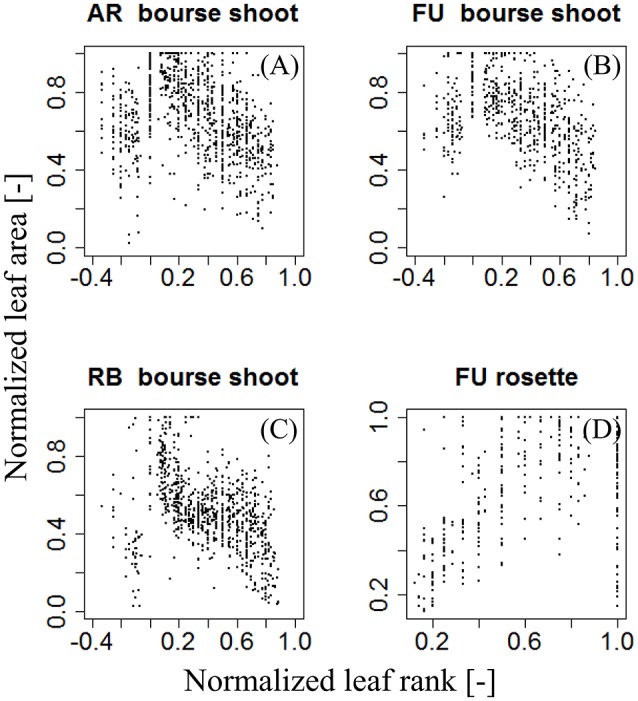
Distribution of individual normalized leaf area plotted against normalized leaf rank of AR, FU, and RB bourse shoots (N = 153, 97, and 112) (A–C) and FU rosettes (N = 80) (D).